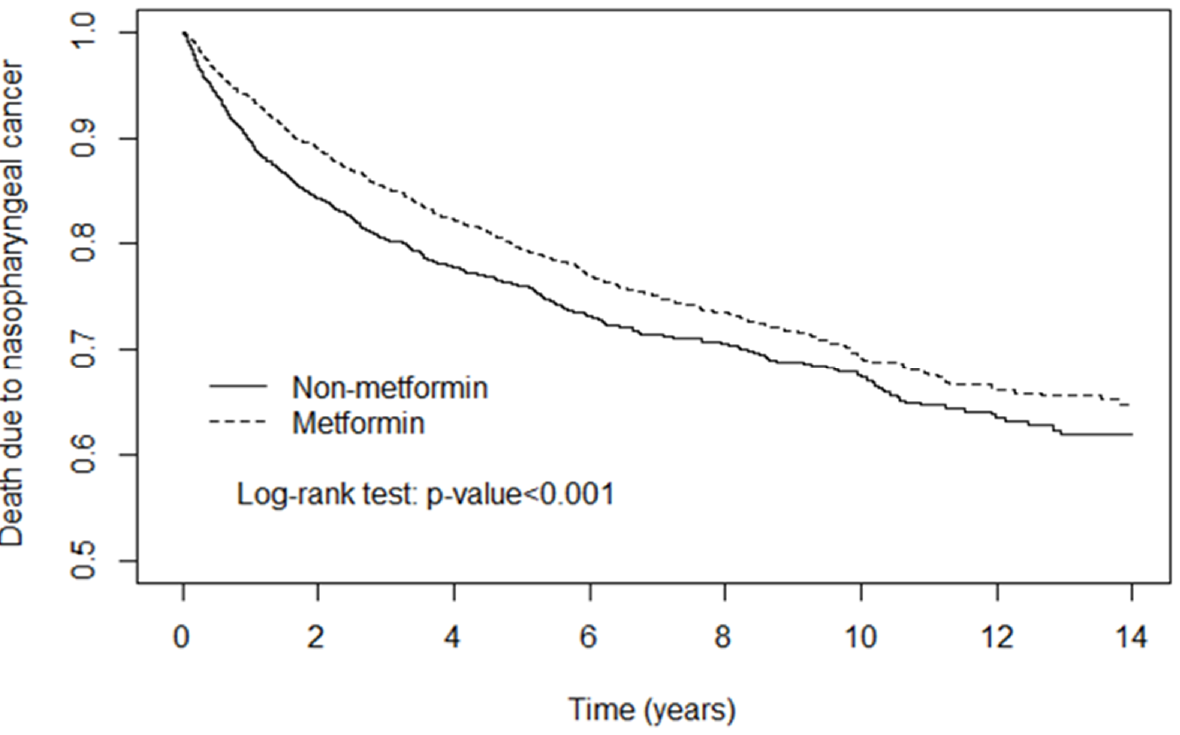
Figure 1. Kaplan–Meier model revealed that the cumulative incidence of death due to nasopharyngeal cancer was lower in the Metformin group than that in the non-Metformin group at the end of the follow-up period ( p < 0.001).